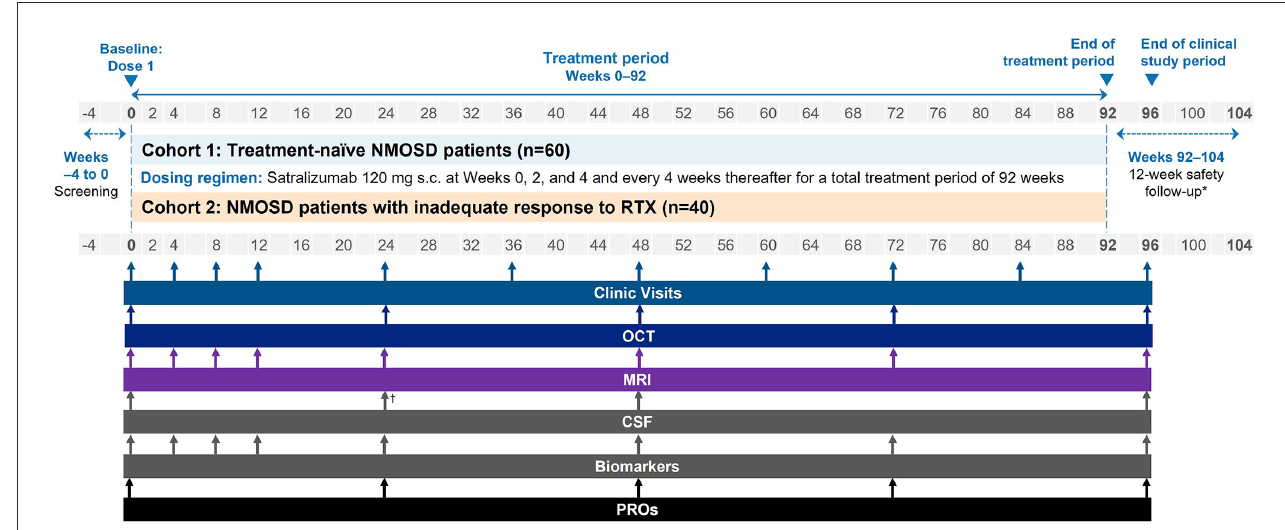
FIGURE1 Study schema. *For participants withdrawing from satralizumab treatment, i.e. those discontinuing early or not continuing with treatment outside of the study. † Optional CSF at Week 24. CSF, cerebrospinal fluid; MRI, magnetic resonance imaging; NMOSD, neuromyelitis optica spectrum disorder; OCT, optical coherence tomography; PRO, patient-reported outcome; RTX, rituximab; s.c.,